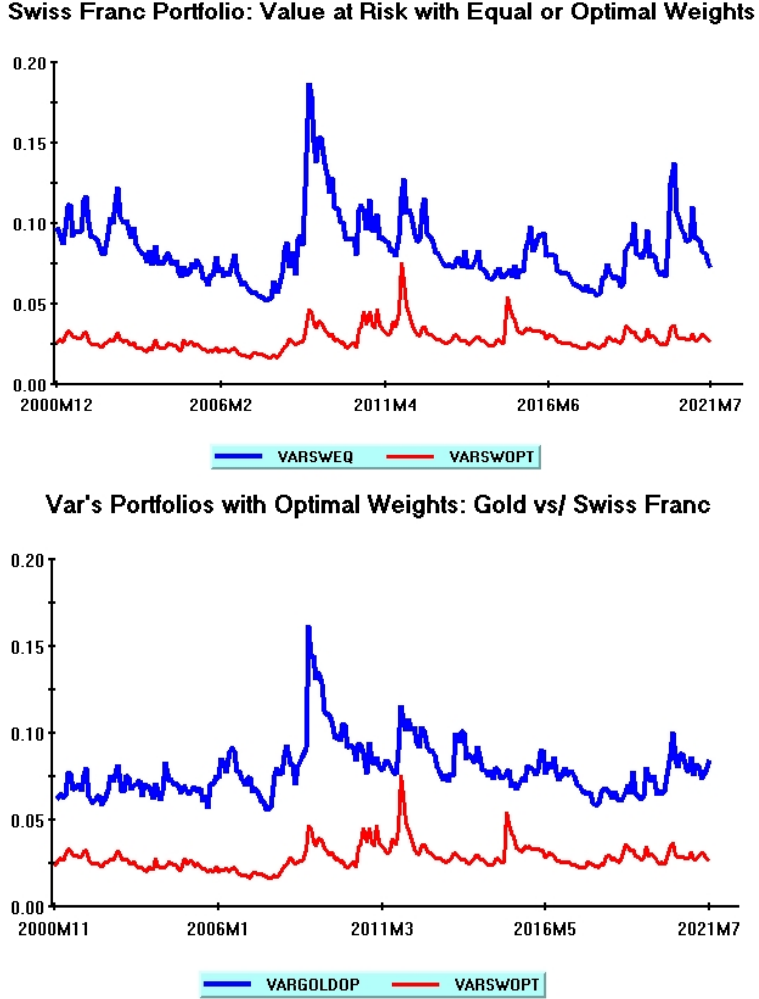
Figure 4. Value at Risk